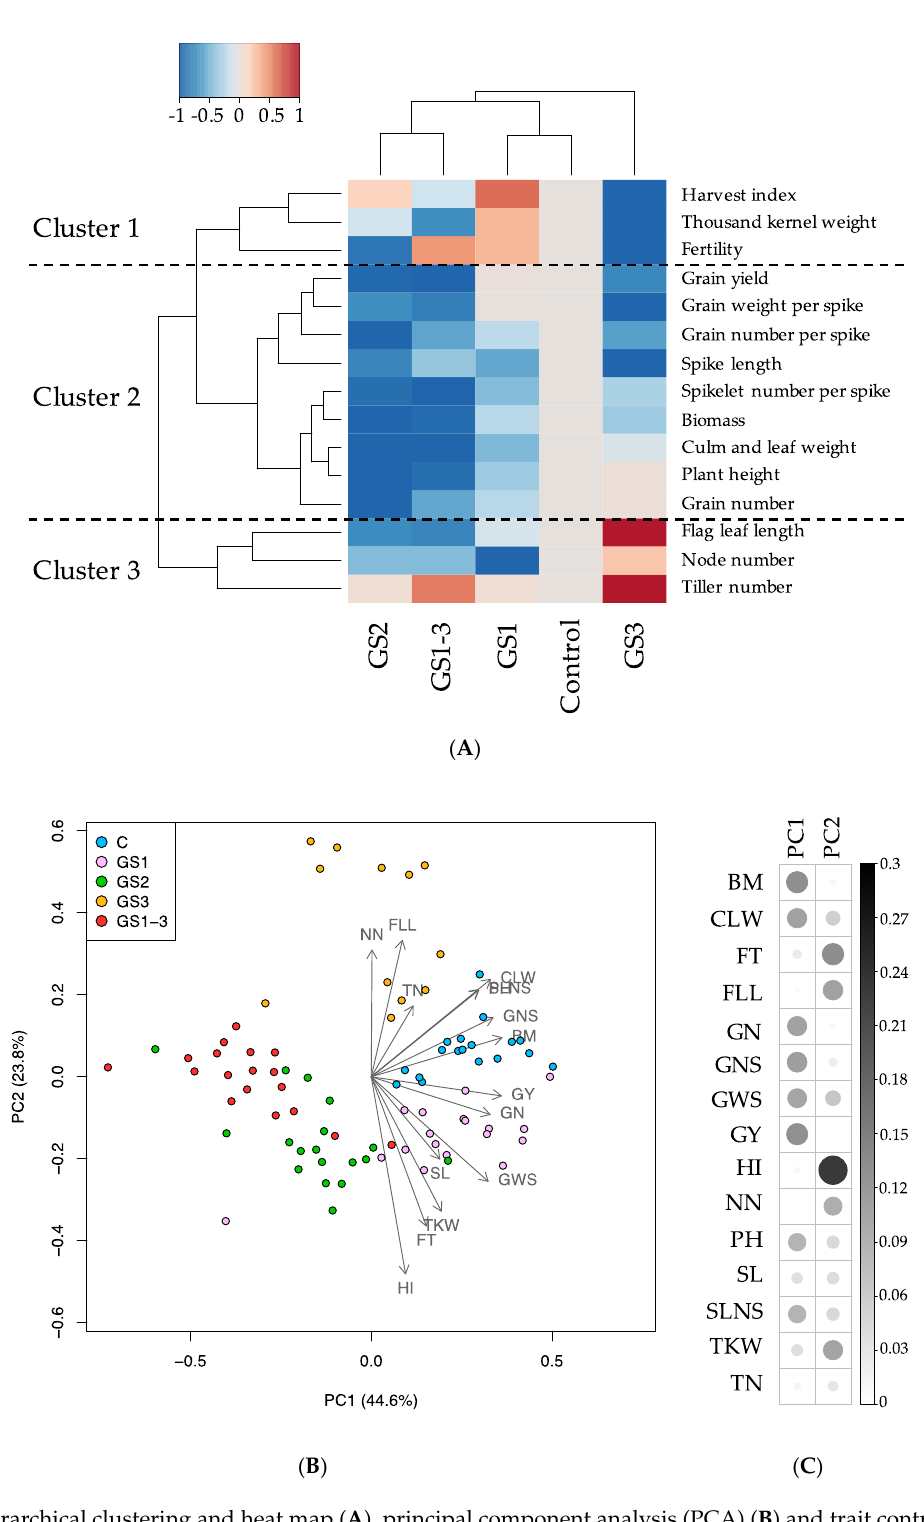
Figure 3. Hierarchical clustering and heat map ( A ), principal component analysis (PCA) ( B ) and trait contribution to PC1 and PC2 ( C ) of agricultural traits in each growing condition (GS1, GS2, GS3, GS1-3 and control indicated by C). Colors in ( A ) show increase (red) or decrease (blue) compared with the control. In ( C ), the strength of the contribution is indicated by the size and intensity of each circle. In ( B , C ), BM, Biomass; CLW, Culm and leaf weight; FT, Fertility; FLL, Flag leaf length; GN, Grain number; GNS, Grain number per spike; GWS, Grain weight per spike; GY, Grain yield; HI, Harvest index; NN, Node number; PH, Plant height; SL, Spike length; SLNS, Spikelet number per spike; TKW, Thousand kernel weight; TN, Tiller